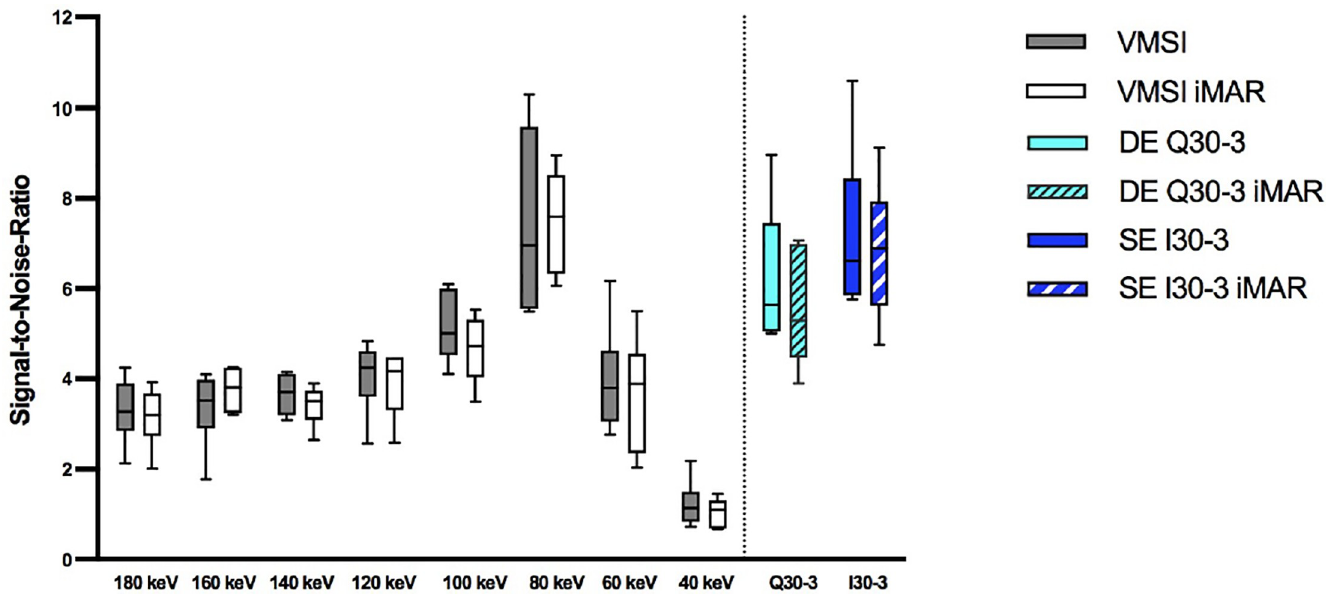
Fig 6. SNR considering the axial slice without